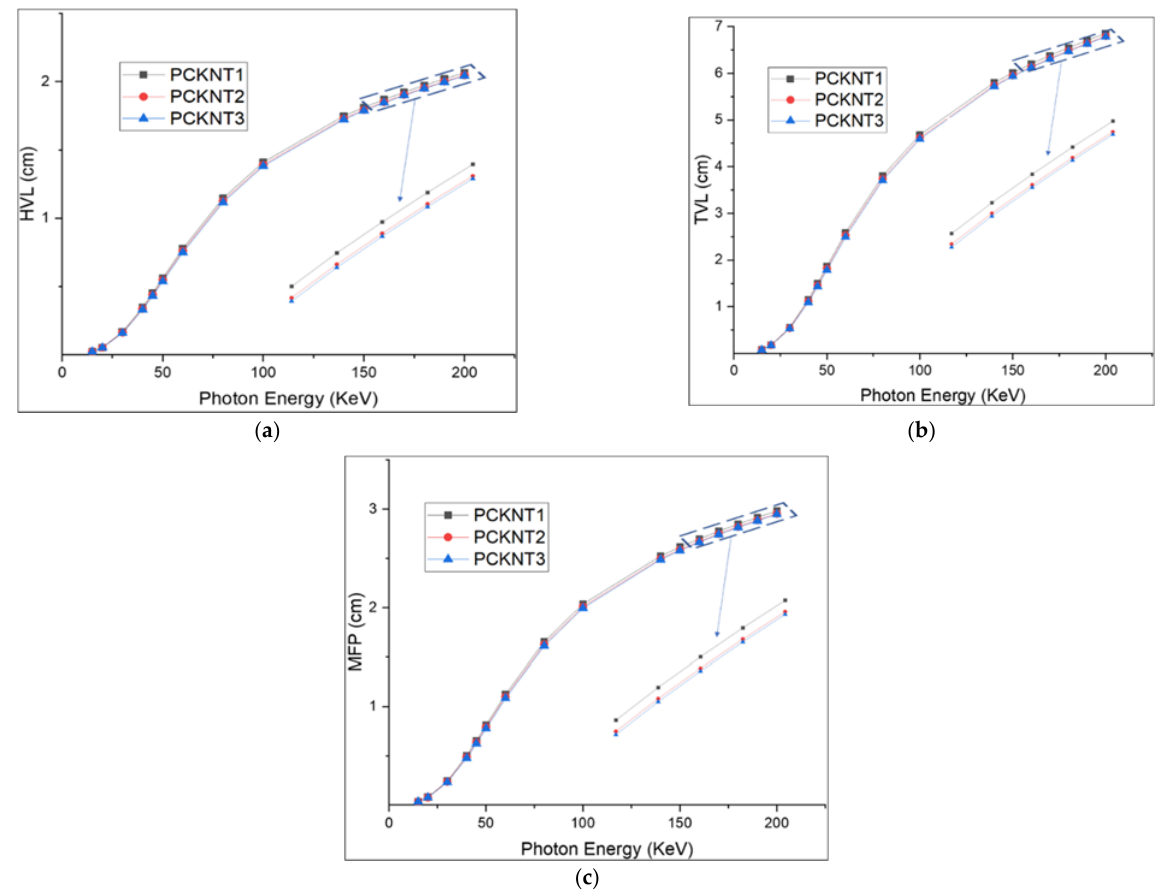
Figure 6. The shielding parameters of TPNK systems: ( a ) HVL, ( b ) TVL, and ( c ) MFP.